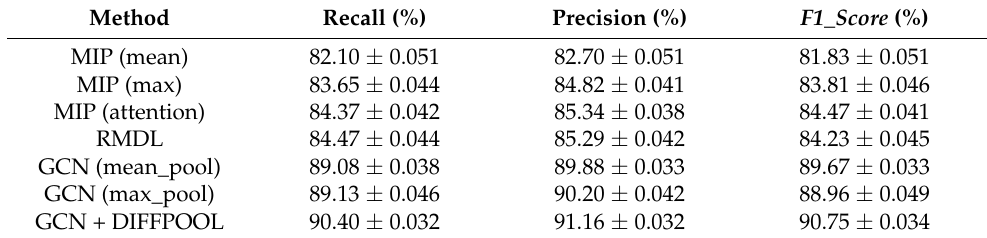
Table 3. Performance of different MIL methods on SRS dataset.